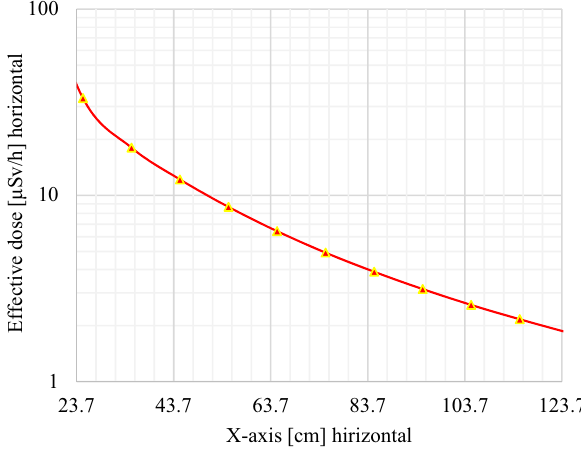
Figure 7. Dose evolution from the DSRSs container’s contact point to 1.00 m away. The effective dose drops from 33.310 ± 0.001 μSv/h at contact to 1.752 ± 0.004μSv/h at 1 m, which is acceptable for the ALARA hypothesis.